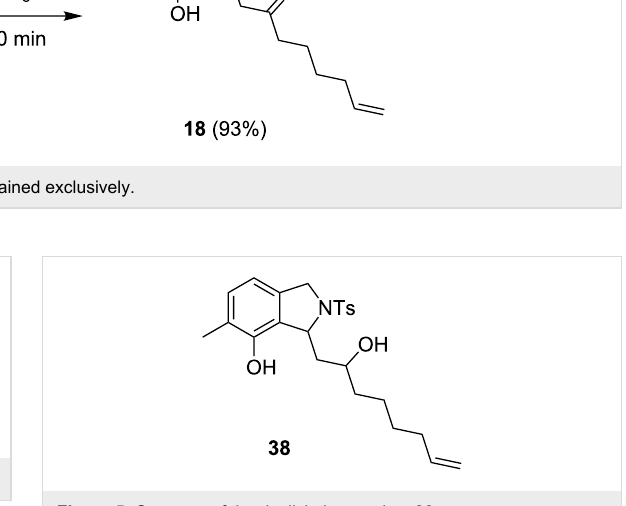
Figure 5: Structure of the desilylation product 38